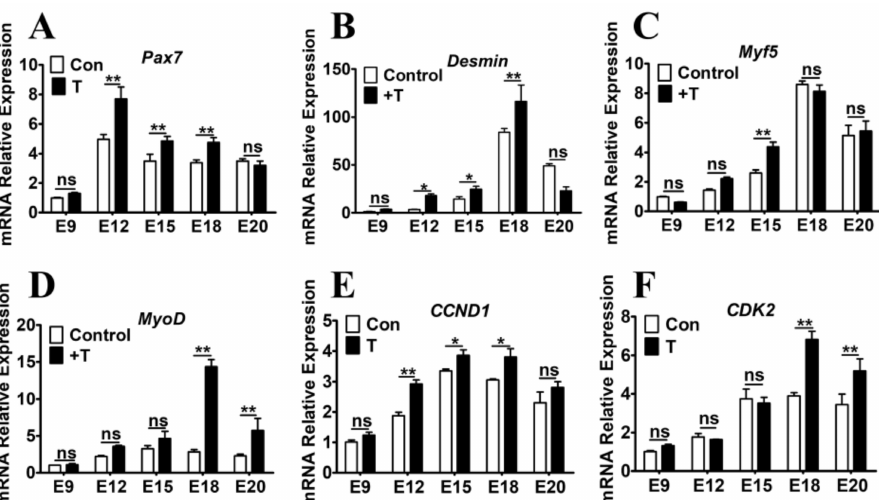
Figure 3. E ff ect of T treatment on genes expression in embryonic chicken skeletal muscles. ( A–F ): The mRNA expression of Pax7 , Desmin , Myf5 , MyoD , CCND1 and CDK2 was detected in the skeletal muscles from the T-treated and control chickens. Data are presented as the means + SE. Asterisk (*) represents statistically di ff erent ( p < 0.05). p < 0.01 is shown as